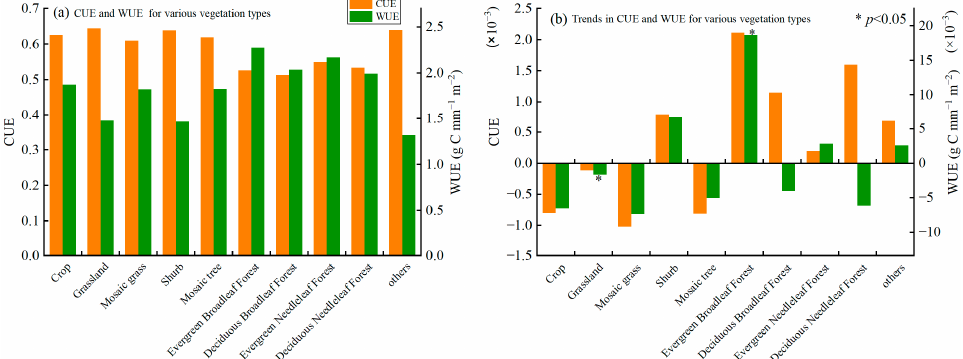
Figure 5. CUE and WUE for various types of vegetation and trend on the Loess Plateau between 2000 and